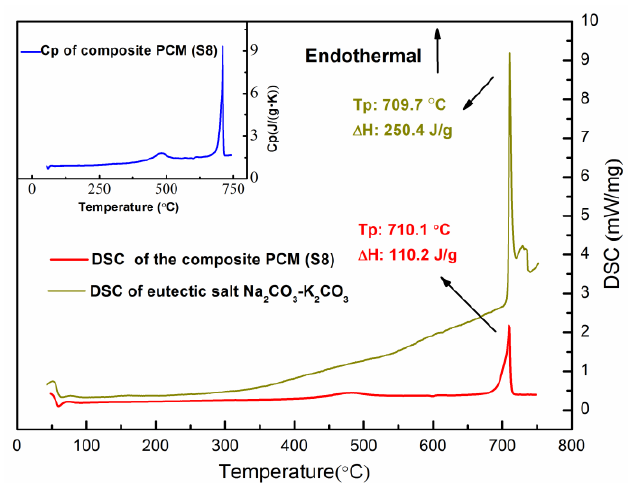
Figure 8. DSC and Cp curves of the composite PCM (Sample S8).